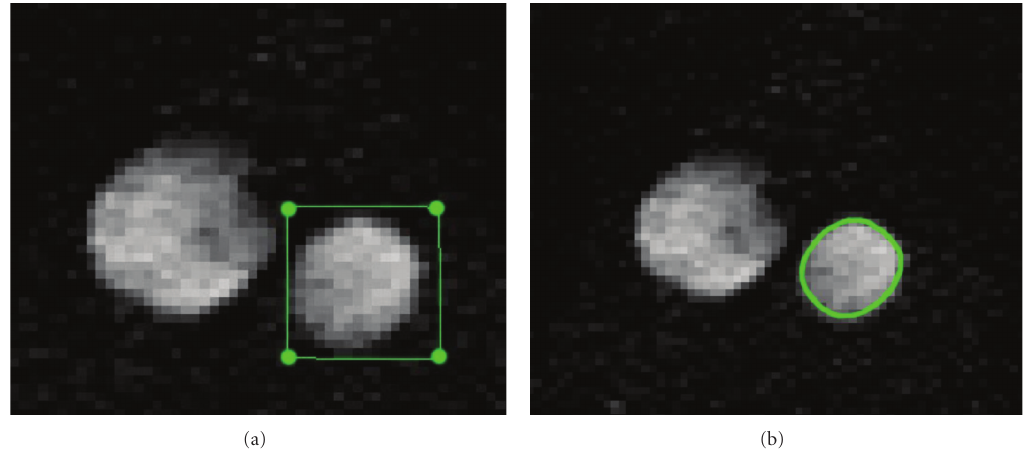
Figure 3: GVF-snakes applied to M2DI sequence. (a) The dots are the starting points applied nearby the aorta. (b) Green line shows the resulting GVF-snake after automatic